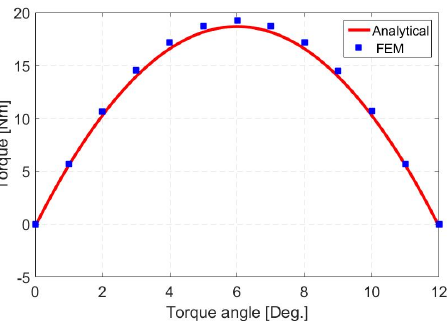
Figure 9. Comparison of the calculated torques with the torque angle by the analytical model and FEM.